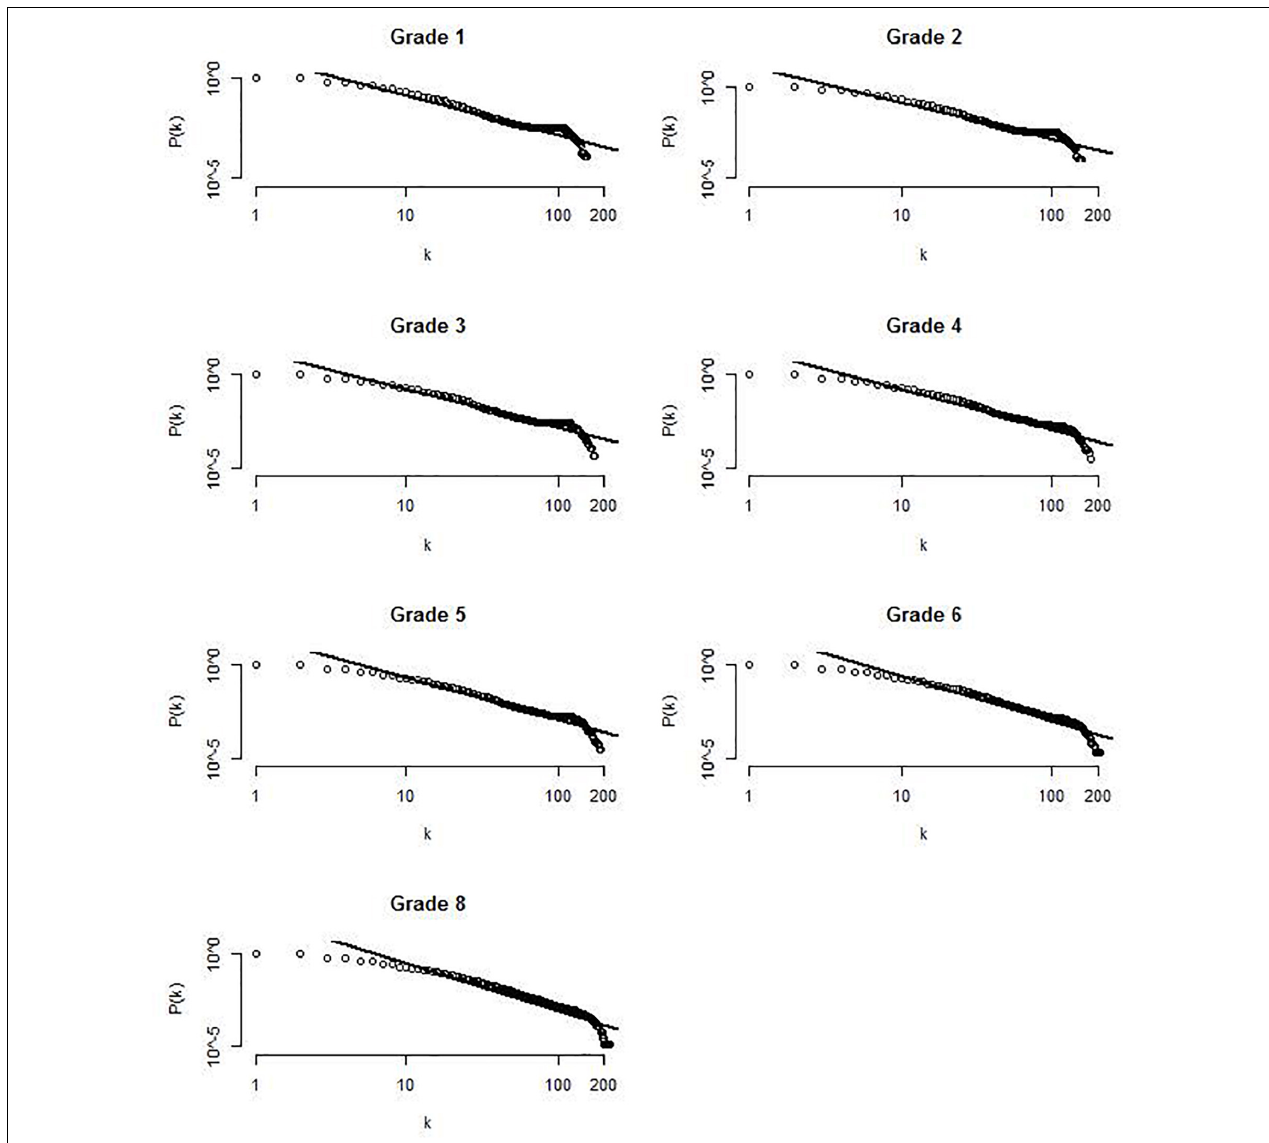
FIGURE 4 | Log-log plot of the degree distribution for one exemplary virtual participant at each time points. Lines represent the fit of a linear function to the